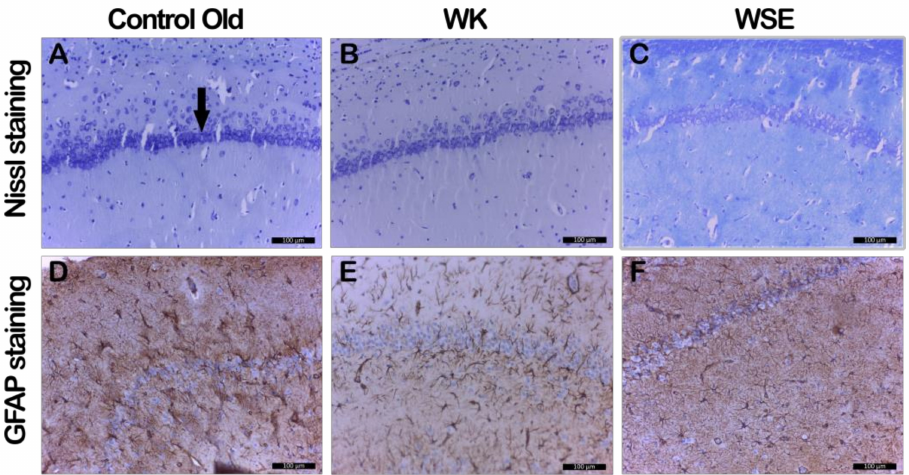
Figure 10. Histopathologic and immunohistochemical changes in naturally aged rats in CA1 region (GFAP– glial fibrillary acidic protein; WK—walnut kernel; WSE—walnut septum extract). ( A – C ) Nissl staining; ( D – F ) GFAP